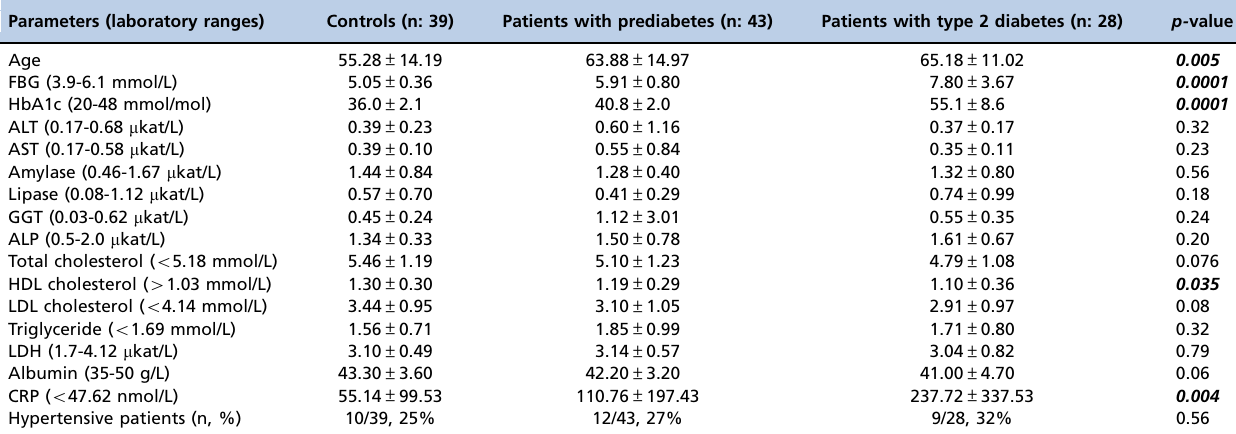
Hypertensive patients (n, %) (FBG: fasting blood glucose, HbA1c: glycosylated hemoglobin, ALT: alanine aminotransferase, AST: aspartate aminotransferase, GGT: gamma glutamyl transferase, ALP: alkaline phosphatase, HDL: high-density lipoprotein, LDL: low-density lipoprotein, LDH: lactate dehydrogenase, CRP: c-reactive protein) (statistically significant p -values were expressed in bold and italic)